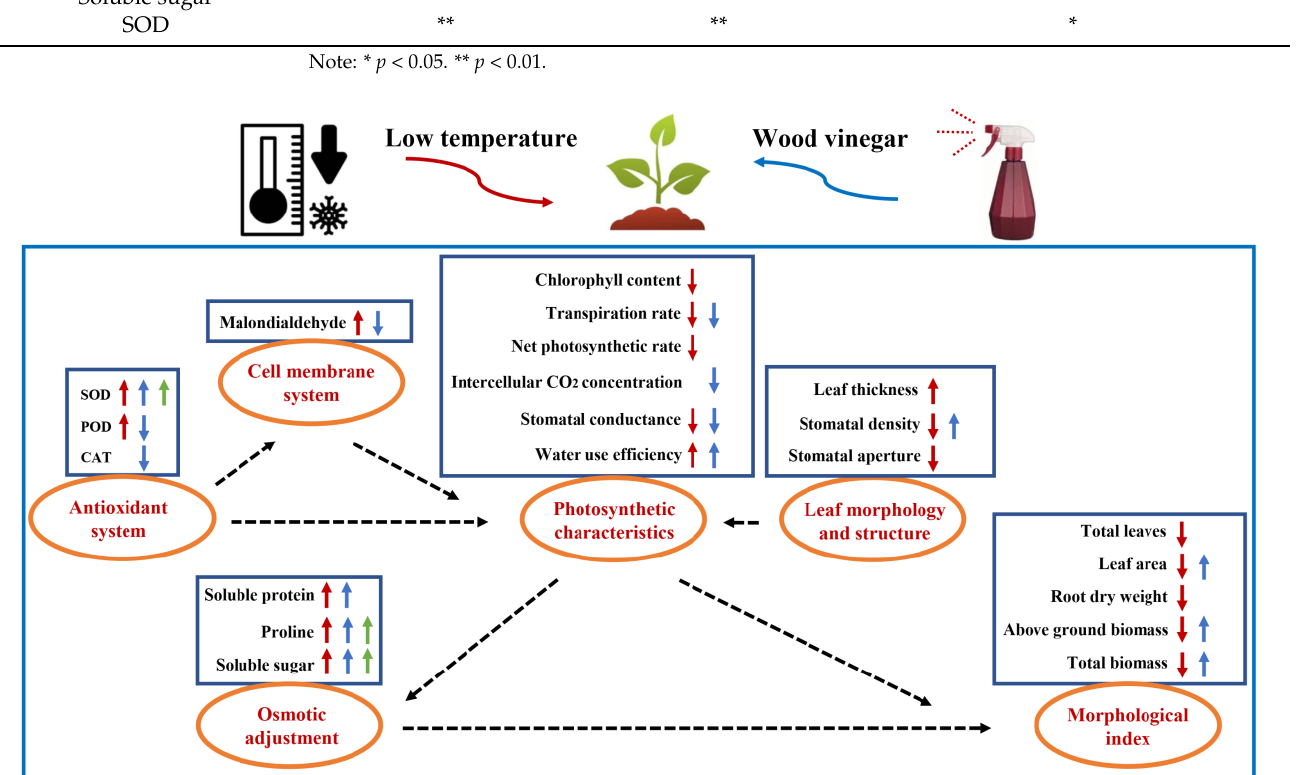
Figure 5. Comprehensive analysis of differences between low temperature and wood vinegar on various indicators of rapeseed. The red, blue, and green arrows represent significant differences in low-temperature treatment, wood vinegar treatment, and low temperature + wood vinegar treatment ( p < 0.05). Upward means increase, and downward means decrease. SOD, superoxide dismutase. POD, catalase. CAT, peroxidase.